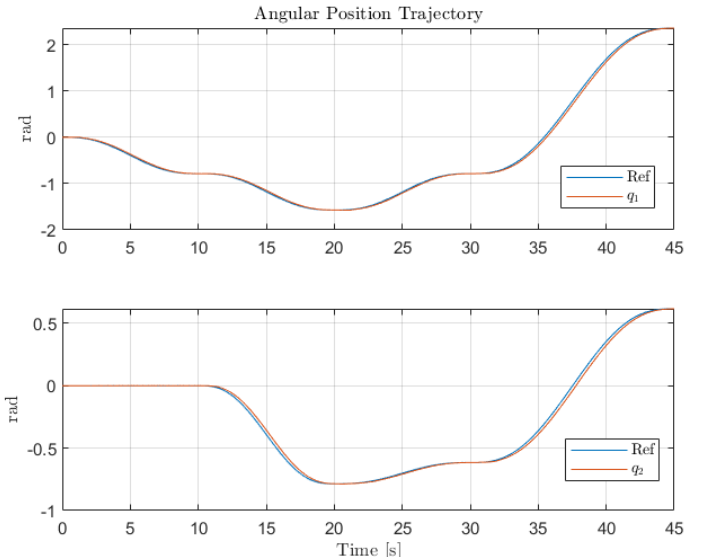
Figure 12. Individual trajectories for q i of Links 1 and 2.